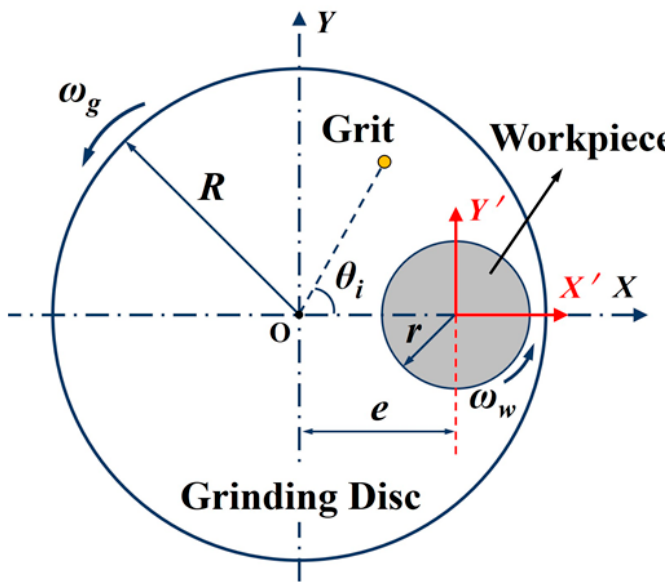
Figure 1. Schematic illustration of the trajectory of a grit during a typical single-side lapping process.